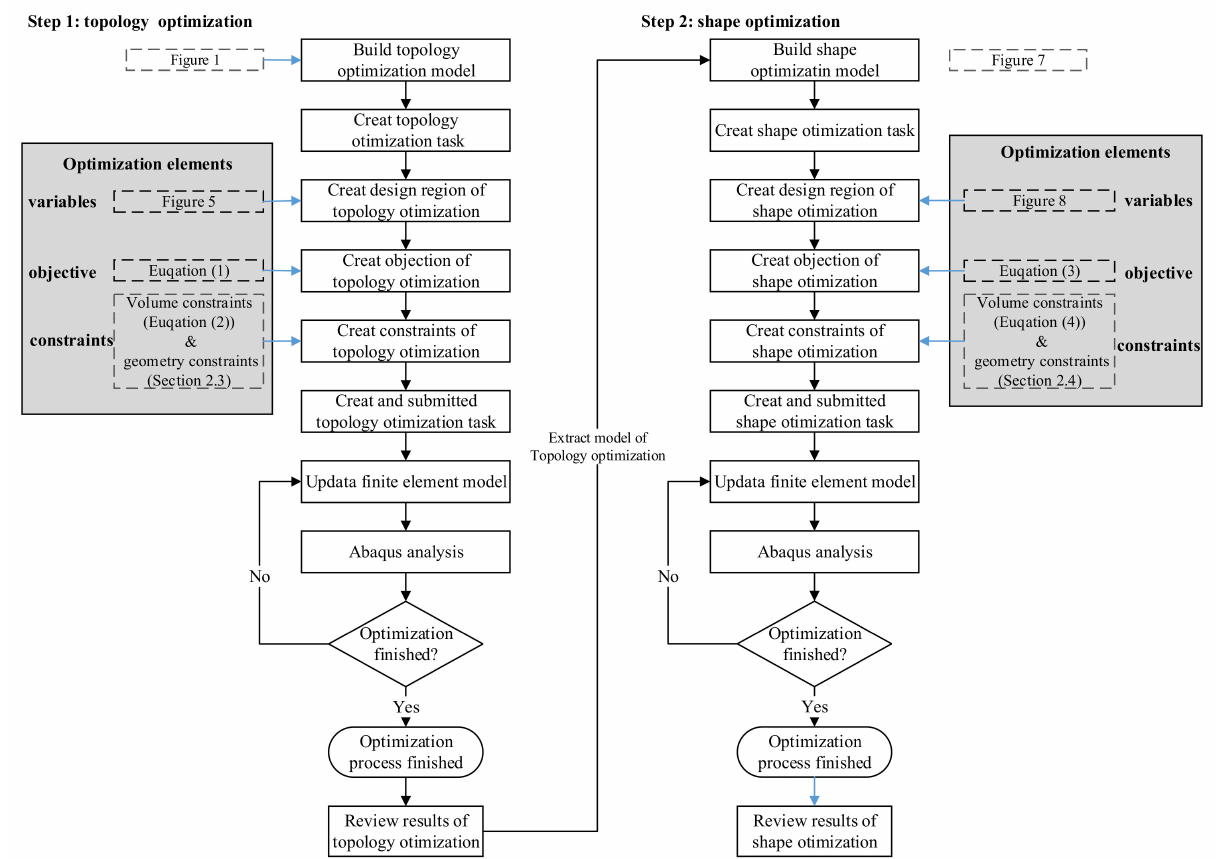
Figure 4. The optimised processes for a classic cruciform specimen.